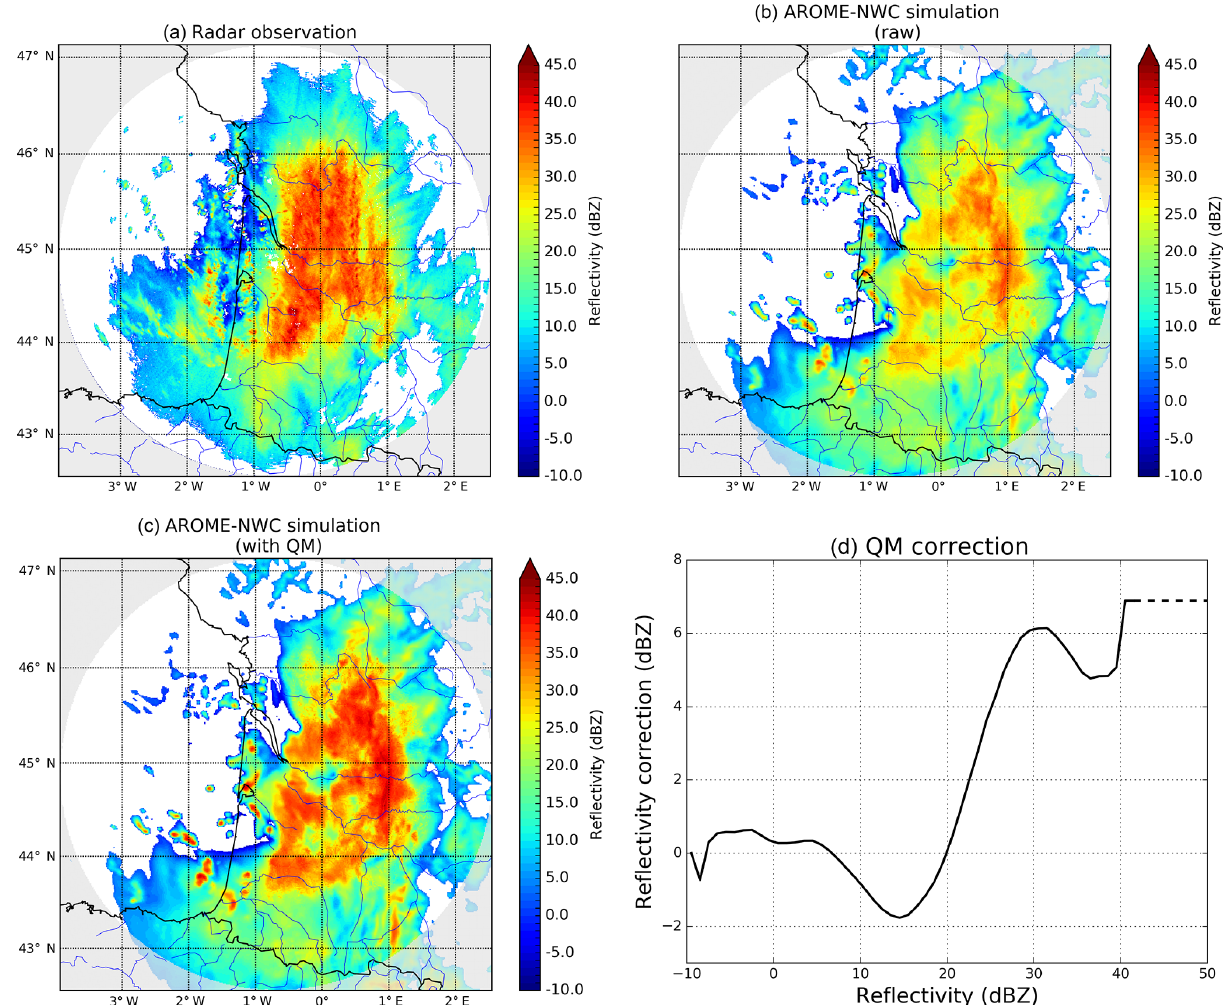
Figure 2. (a) Observed radar reflectivity from the radar of Bordeaux at the elevation 0.4 ◦ on 3 March 2017 at 23:00UTC. (b) Corresponding raw simulated radar reflectivity from AROME-NWC (run of 21:00UTC). (c) Same as (b) but corrected by quantile mapping. (d) Reflectivity correction Cz resulting from the quantile mapping. The extension of the correction for higher reflectivities is represented by dashed